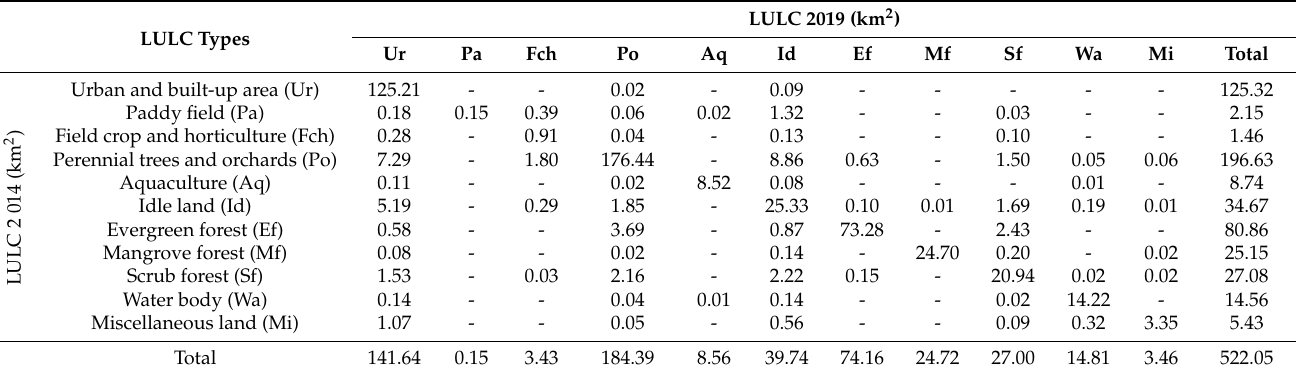
Table 9. LULC change between 2014 and 2019 as a transition area